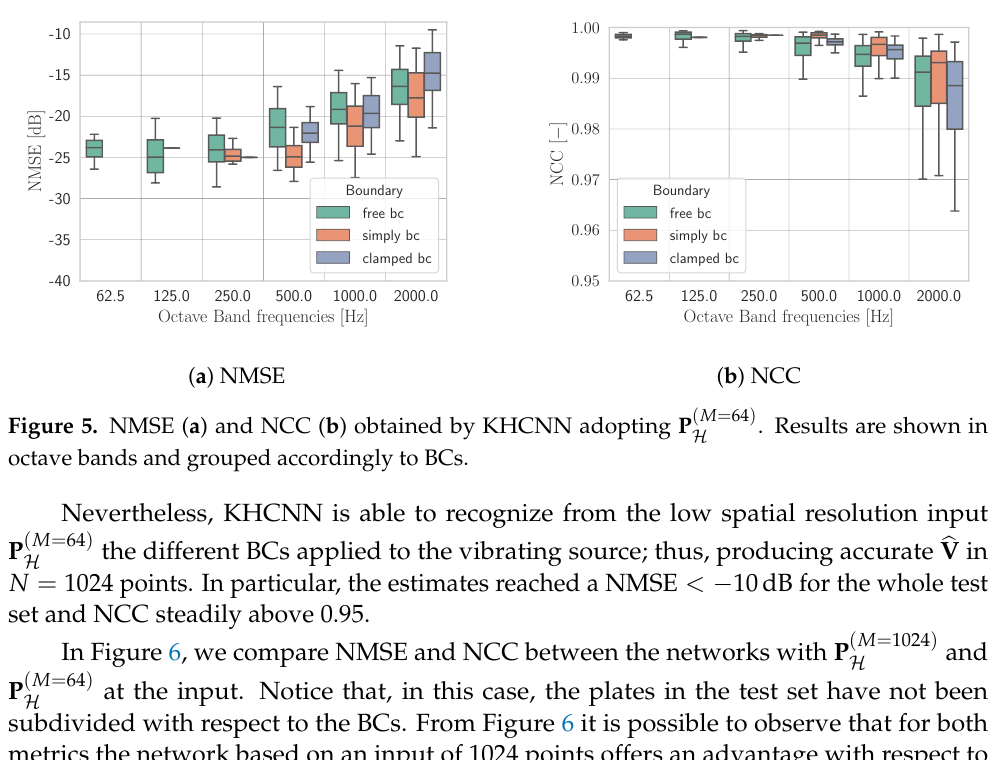
. Results are shown in H